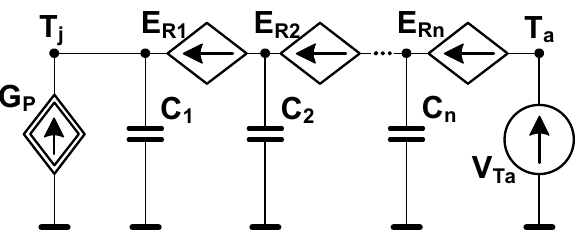
Figure 3. Network form of the non-linear thermal model of the SiC BJT.